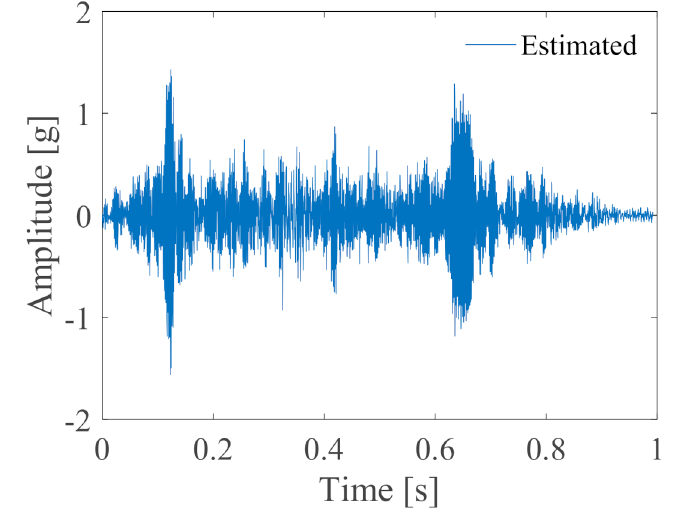
Figure 8. Estimated sensitive signal in outer race fault